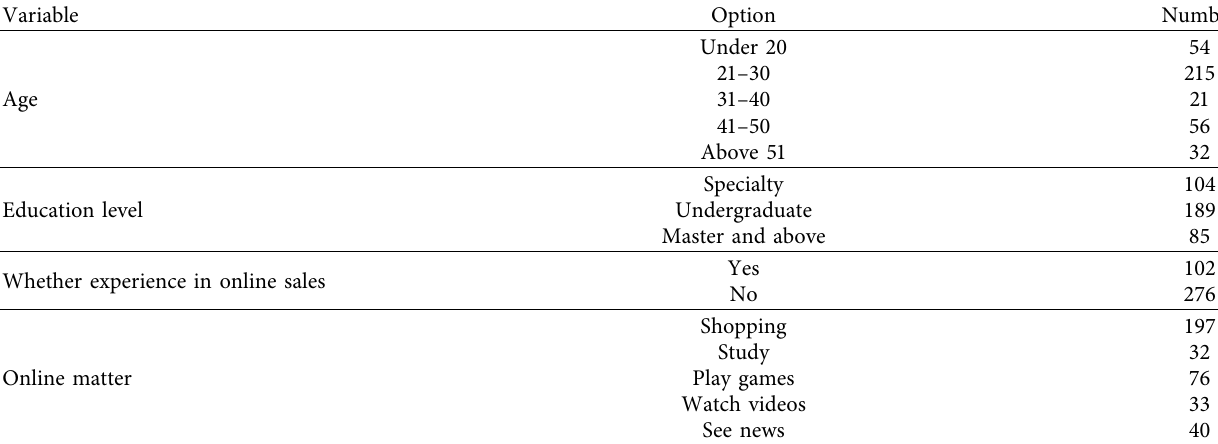
Table 3: Results of the specific sample data situation.